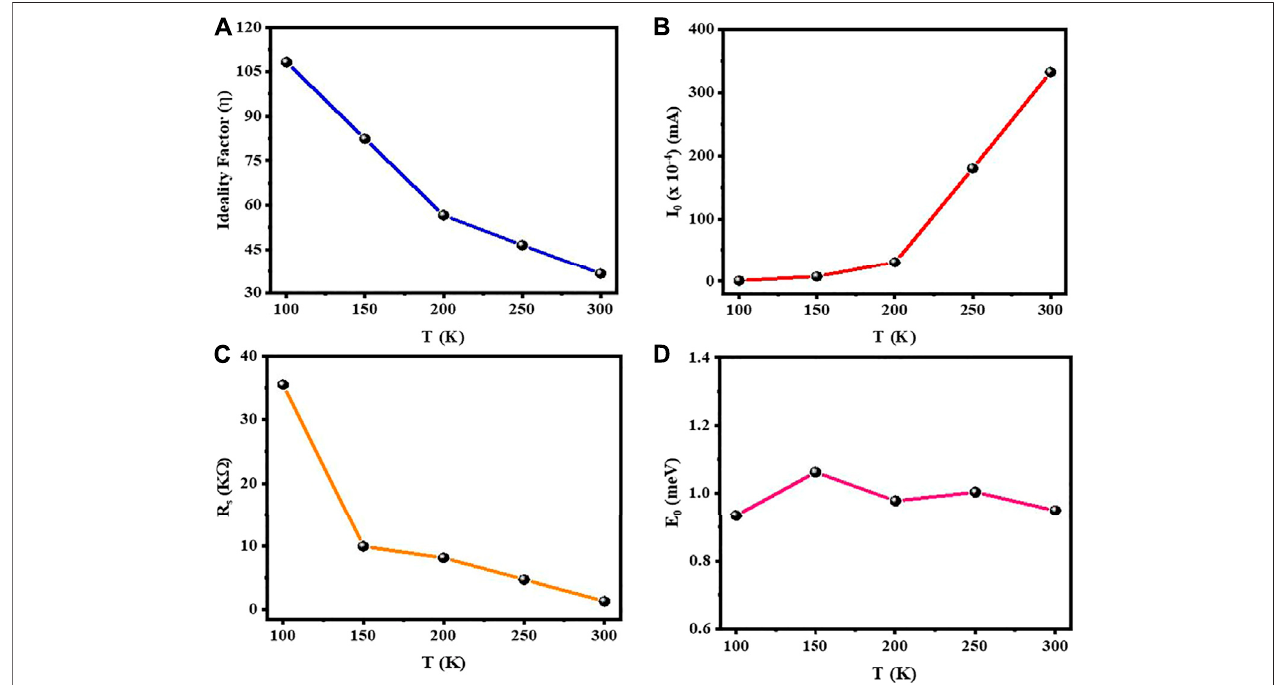
FIGURE 6 | Variation of the (A) ideality factor, (B) tunneling saturation current, (C) series resistance, and (D) tunneling constant of the NZFO/MgO/p-Si heterojunction with temperature.